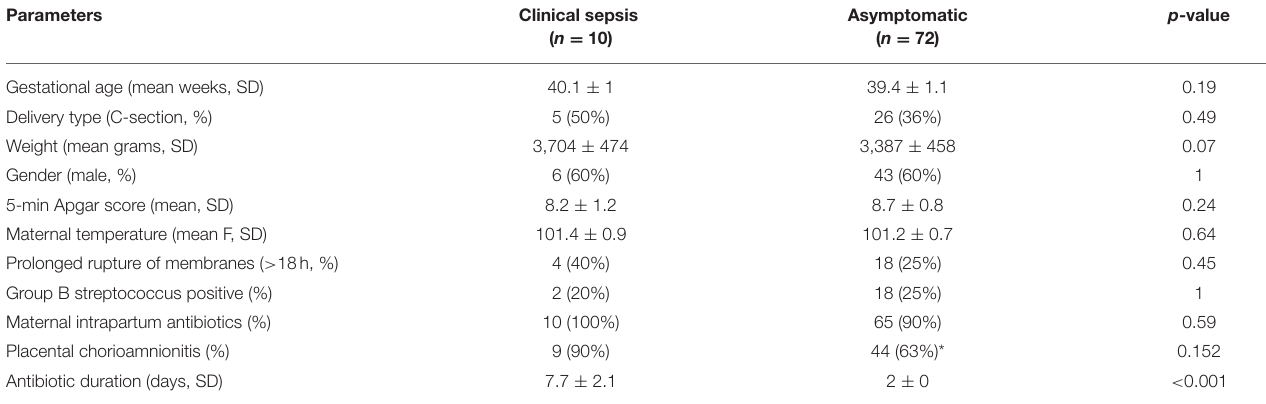
TABLE 1 | Neonatal and maternal characteristics.